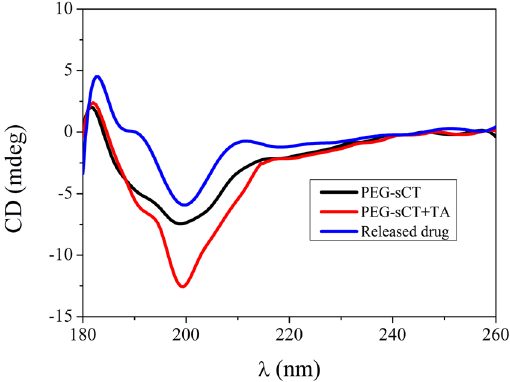
Figure 6. CD spectra of a solution of native PEG-sCT, mixed solution of PEG-sCT and TA, and release media into which PEG-sCT and TA released.